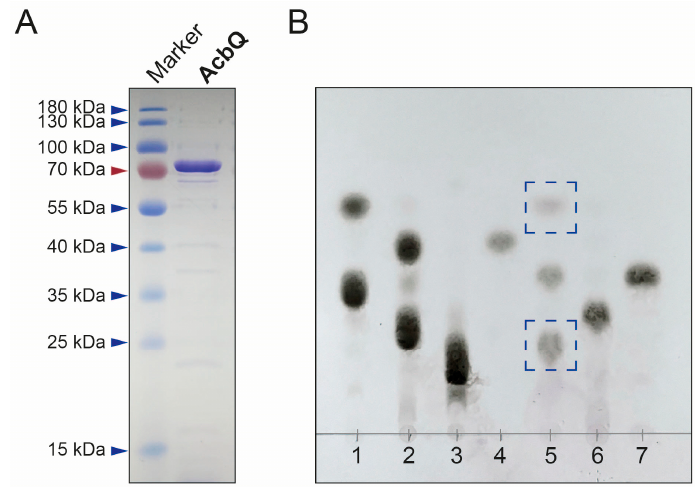
Figure 2. Purification and functional analysis of 4- α -glucanotransferase AcbQ of Actinoplanes sp. SE50/110. ( A ) SDS-PAGE analysis of recombinant His-tagged AcbQ protein from E. coli JM109. ( B ) TLC analysis of enzymatic function of AcbQ. Lanes 1–7 represent the separation of standard sugars and in vitro assays of AcbQ in combinations with different substrates. 1: Standard sugars glucose (G1) and maltotriose (G3). 2: Standard sugars maltose (G2) and maltotetraose (G4). 3: Standard sugar maltopentaose (G5). 4: Assay with G2. 5: Assay with G3. 6: Assay with G4. 7: Assay with inactivated AcbQ and G3 (negative control). Blue boxes indicate the formation of new products.